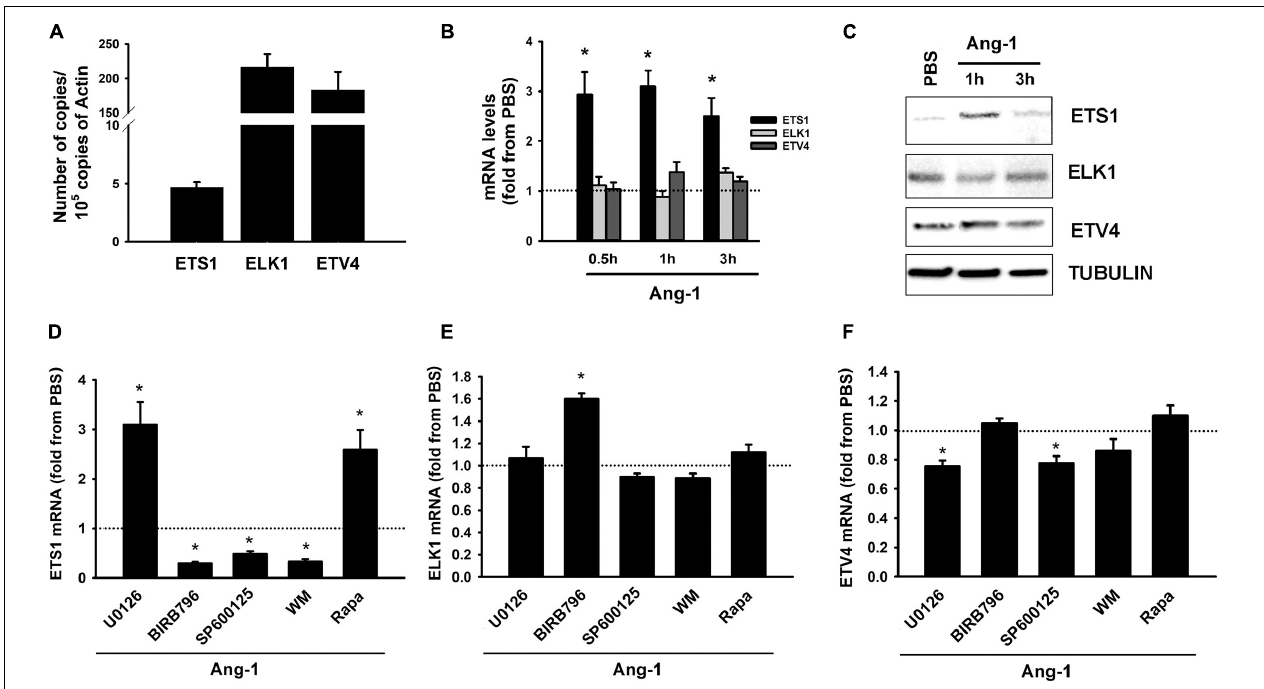
FIGURE 2 | Ang-1 regulates ETS TF expression and DNA binding activity. (A) Relative abundance of ETS1, ELK1, and ETV4 mRNA in HUVECs maintained in complete medium. Values are means ± SEM, expressed as number of copies per 10 5 copies of β -ACTIN. N = 4 per group. (B) mRNA levels of ETS1, ELK1, and ETV4 in HUVECs exposed to PBS or Ang-1 (300 ng/ml) for 30 min, 1, or 3 h. Values are means ± SEM, expressed as fold relative to PBS. * P < 0.05, compared to PBS. N = 6 per condition. (C) Protein expression of ETS1, ELK1, and ETV4 in HUVECs exposed to PBS or Ang-1 for 1 h and 3 h. (D–F) mRNA levels of ETS1, ELK1, and ETV4 in HUVECs pre-incubated for 1 h with various pathway inhibitors then exposed to PBS or Ang-1 for 1 h. Values are means ± SEM, expressed as fold from PBS. * P < 0.05, compared to PBS. N = 6 per condition.